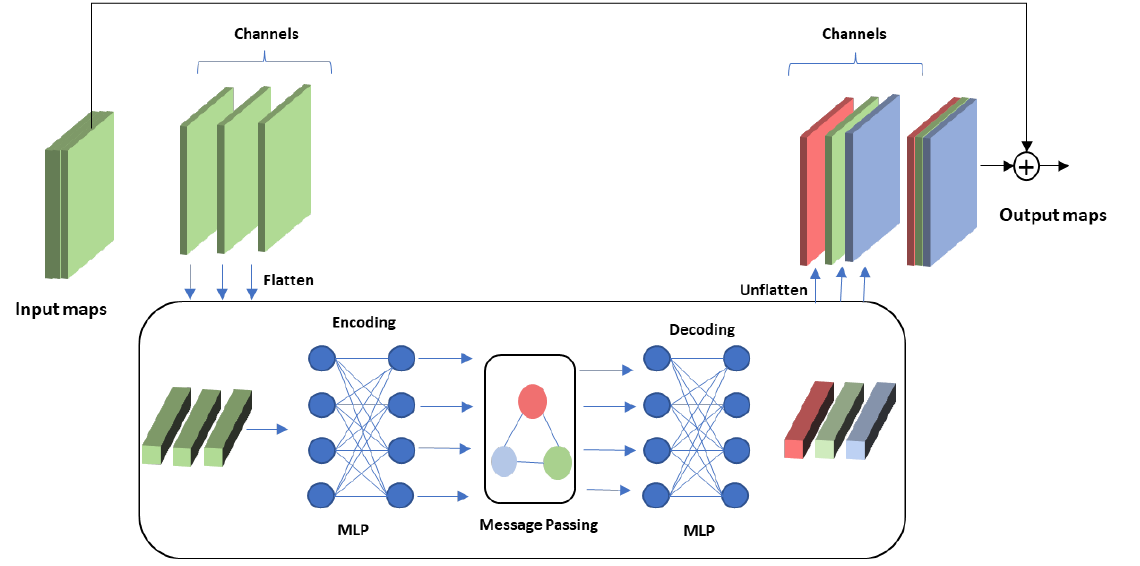
Figure 2. Working of cross-channel-communication Block.